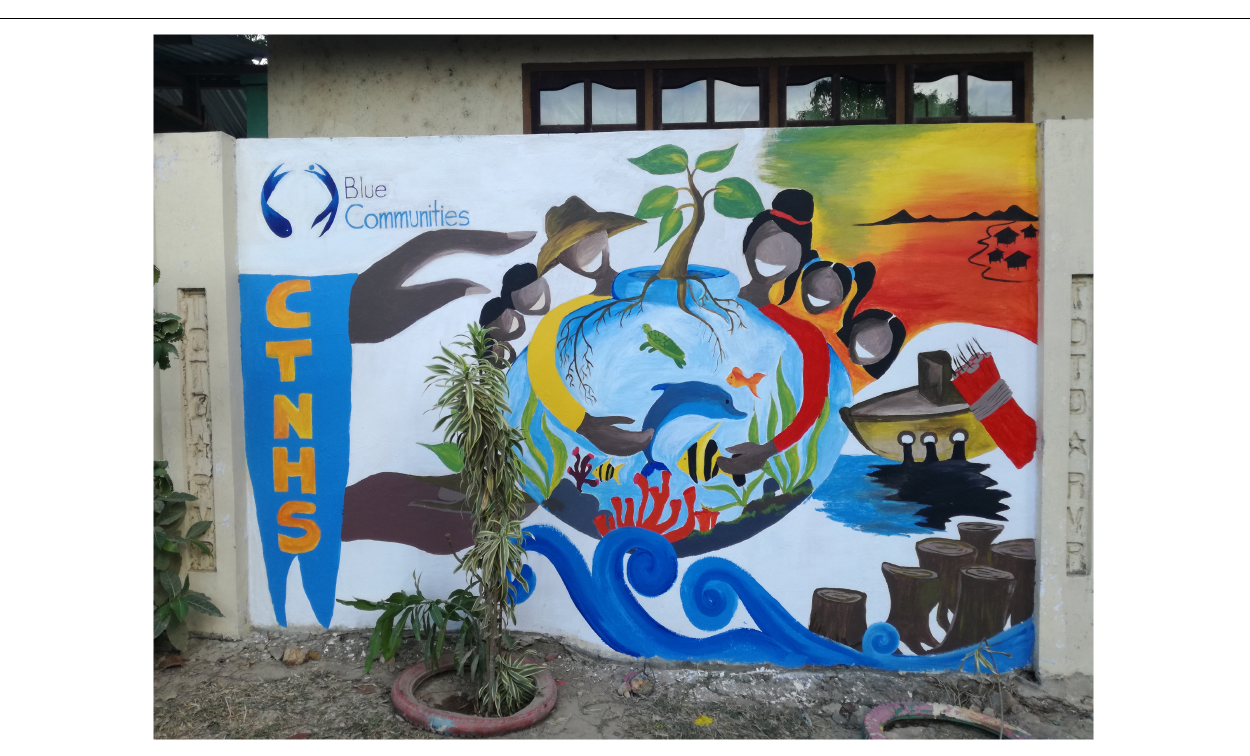
for the level of enjoyment of activity 2 , gender and age. To 2 The pattern of results and significance levels remain the same if the variables enjoyment of activity, gender and age are added or removed. This rules out that our effects are based on the participants’ enjoying of the group work rather than on the engagement with the scenario content.